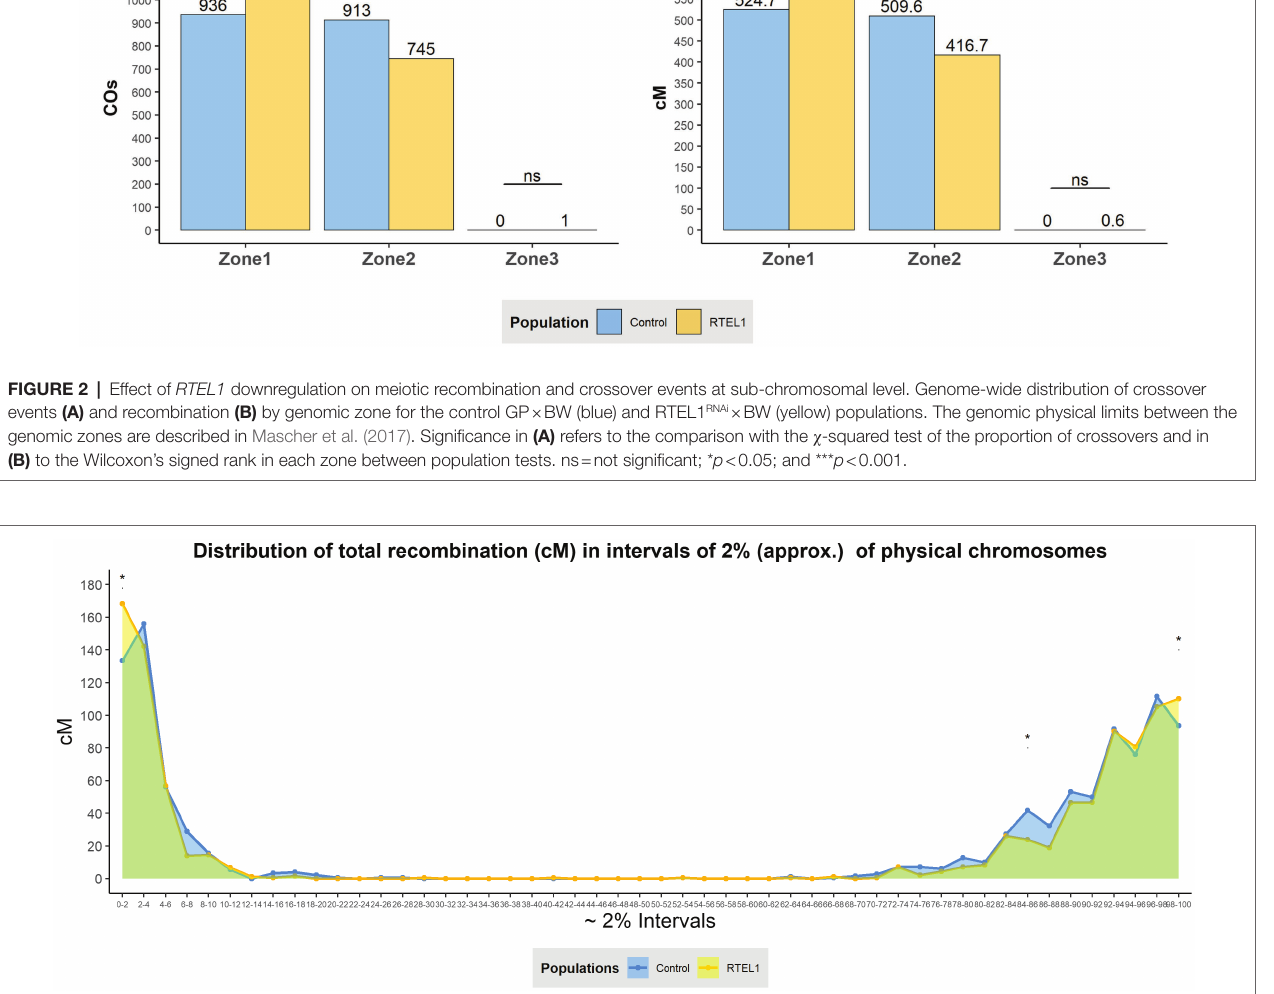
FIGURE 3 | Effect of RTEL1 downregulation on total meiotic recombination distribution at 2% chromosomal windows. Genome-wide recombination distribution by intervals of physical 2% for the GP × BW (blue) and RTEL1 RNAi × BW (yellow) populations. The differences between populations were tested for every interval with the Wilcoxon’s signed rank test being * p < 0.05. The green area under the lines shows the shared recombination regions by both populations, whilst blue or yellow show regions where only the control or RTEL1 RNAi populations recombine,